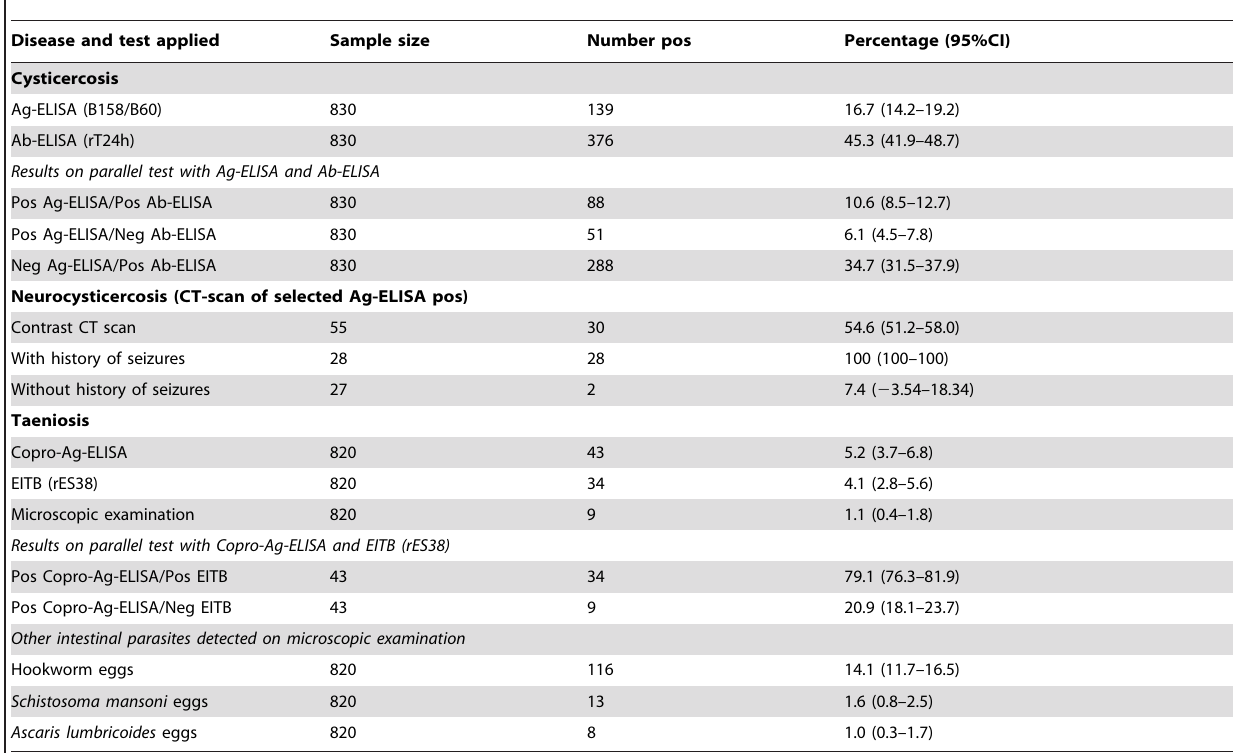
Table 1. Prevalence of Taenia solium and other helminth infections in Mbozi district, Mbeya Region, Tanzania.